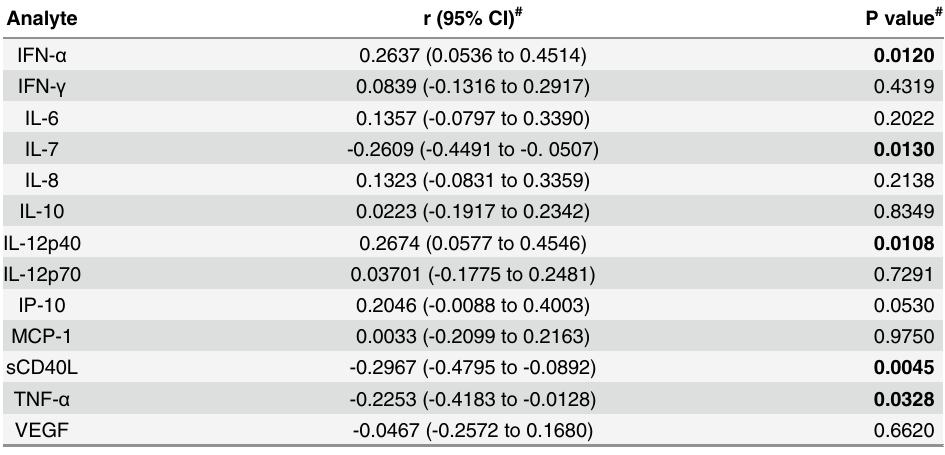
Table 5. Correlation of viremia with secreted biochemical